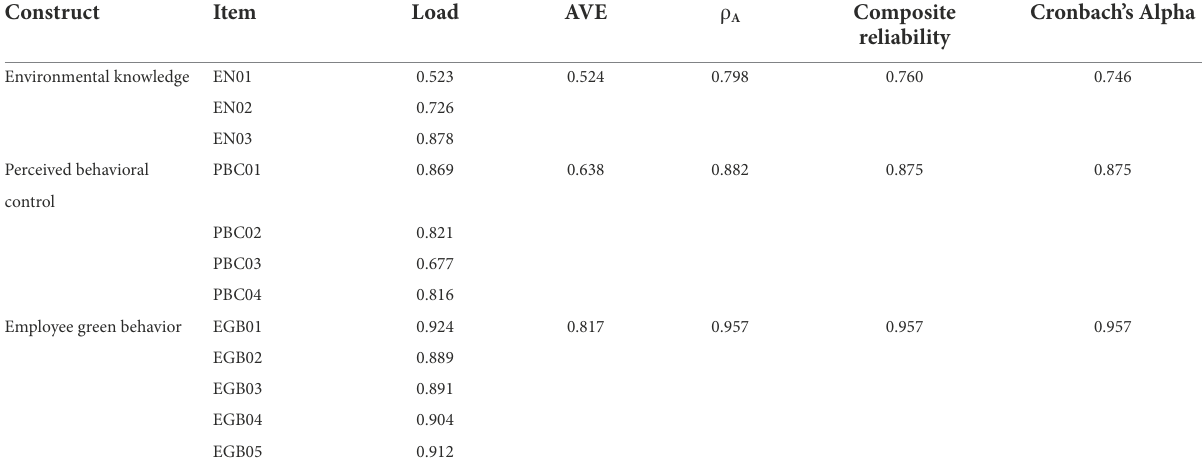
TABLE 2 The values of internal consistency and convergent validity.